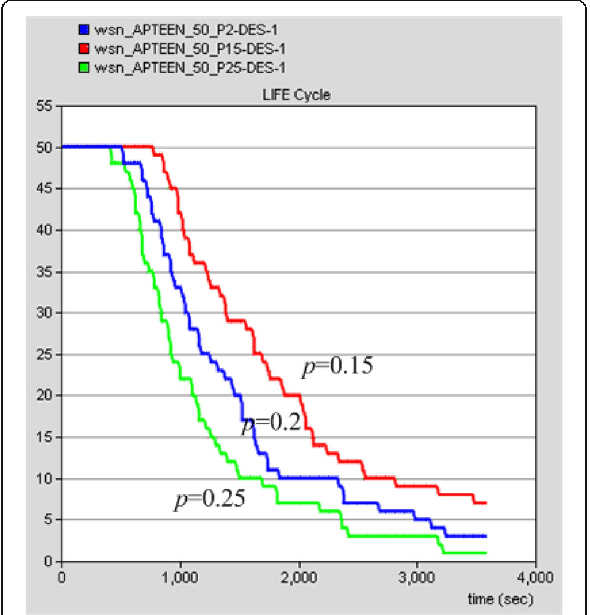
Fig. 8 The life cycle of APTEEN in different probability. Network life cycle comparison with probabilities is 0.15, 0.2, and 0.25 respectively in the 50-node network scene. As can be seen from the figure, the smaller p values selected, the longer network life cycle